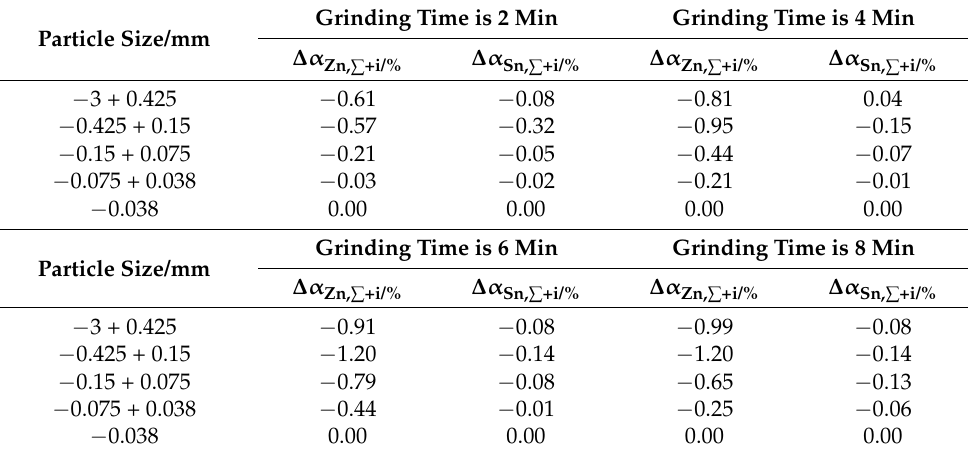
Figure 9. Changes in the cumulative grade for different size fractions and different grinding times when the mill speed is 85 r/min. ( a ) Changes in the cumulative grade for Zn. ( b ) Changes in the cumulative grade for Sn. Table 10. Changes in the cumulative grade for different grinding times when the mill speed is 85